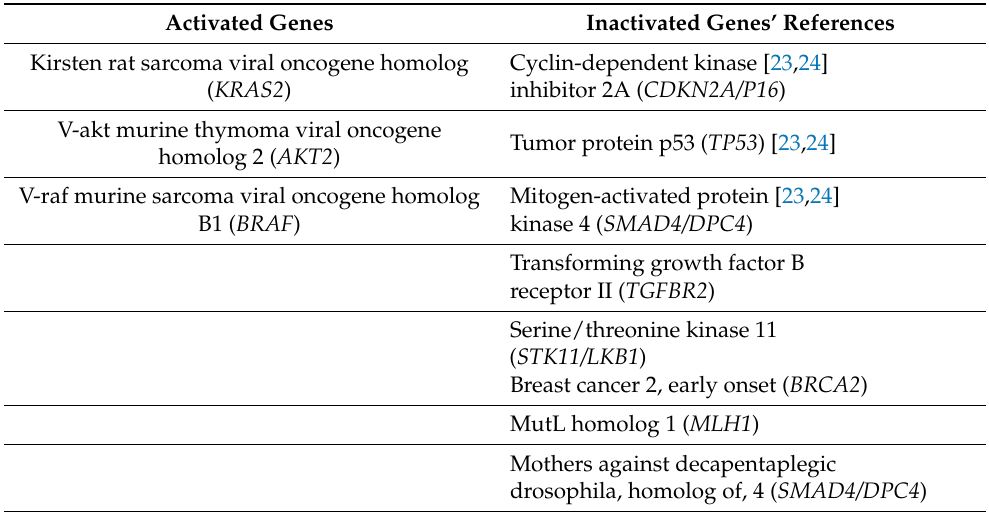
Table 3. Summary of molecular signatures, both activated and inactivated, that are thought to be important in the pathogenesis of pancreatic cancer besides others listed in Table